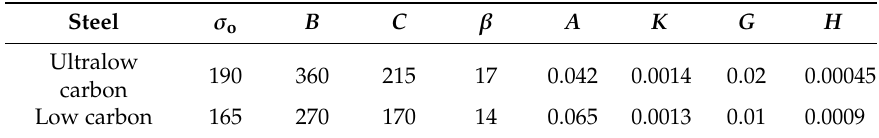
Figure 36. Comparison of the predicted and experimental yield strength at varying strain rates for ( a ) low carbon steel and ( b ) ultralow carbon steel [22]. Table 3. Material constant for the proposed model [22] .